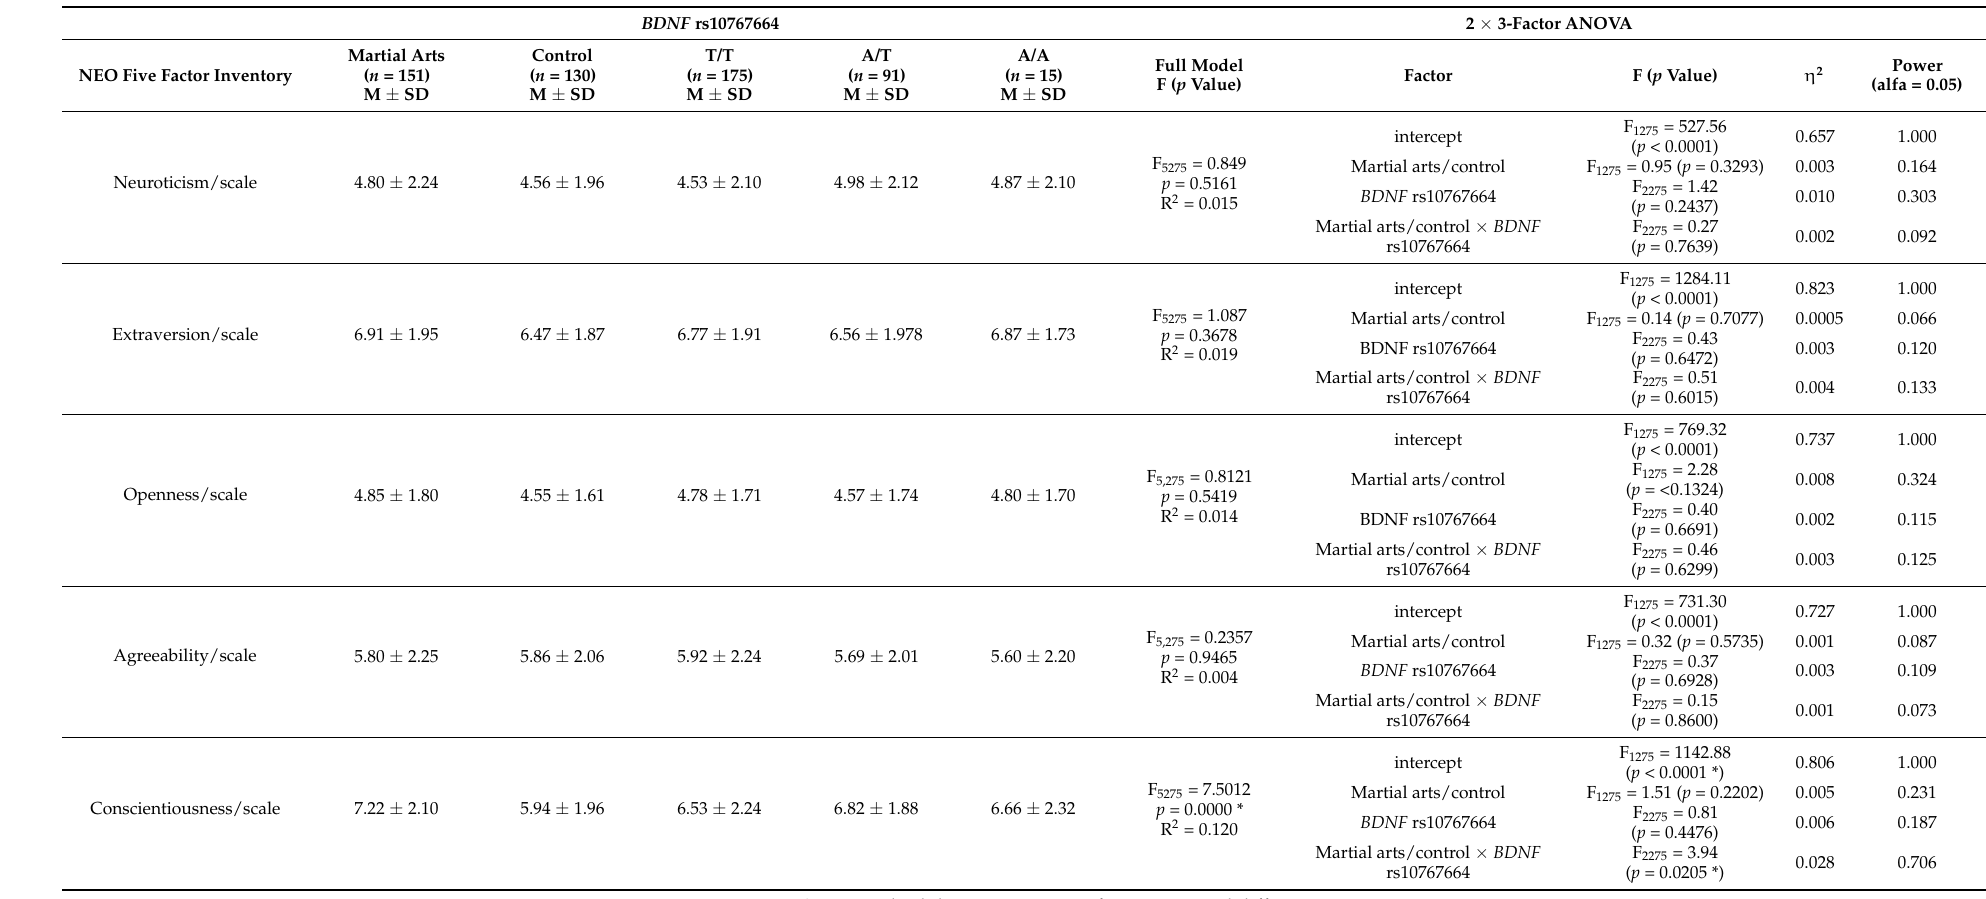
M—mean, SD—standard deviation. *—significant statistical